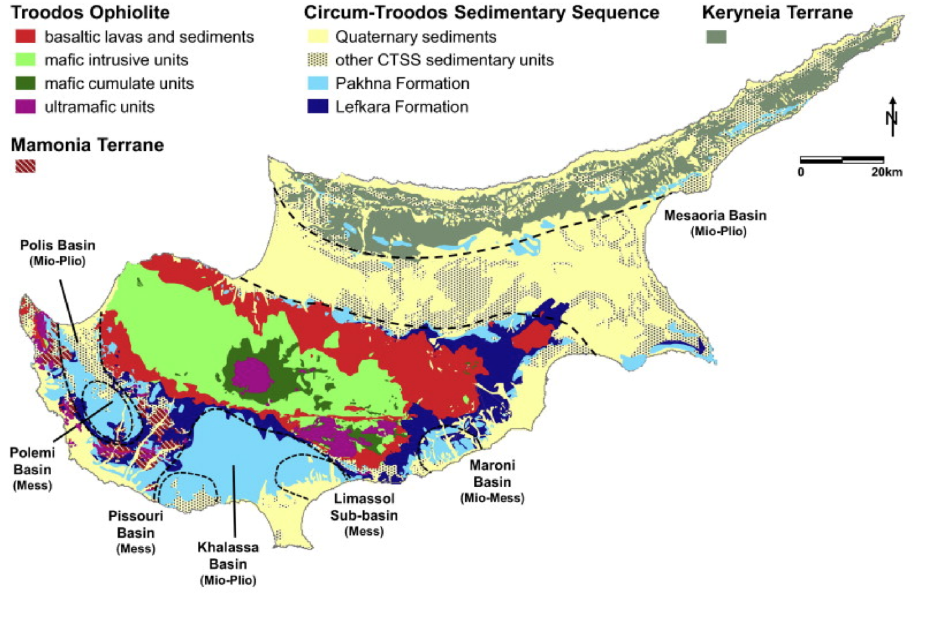
Figure 2. A map showing the geological formations of Cyprus. The Troodos Massif, the Mesaoria basin, and the Lefkara formation provided the natural resources that ancient artists used to prepare their pigments and plasters layers for wall paintings (image adapted from Ren et al.